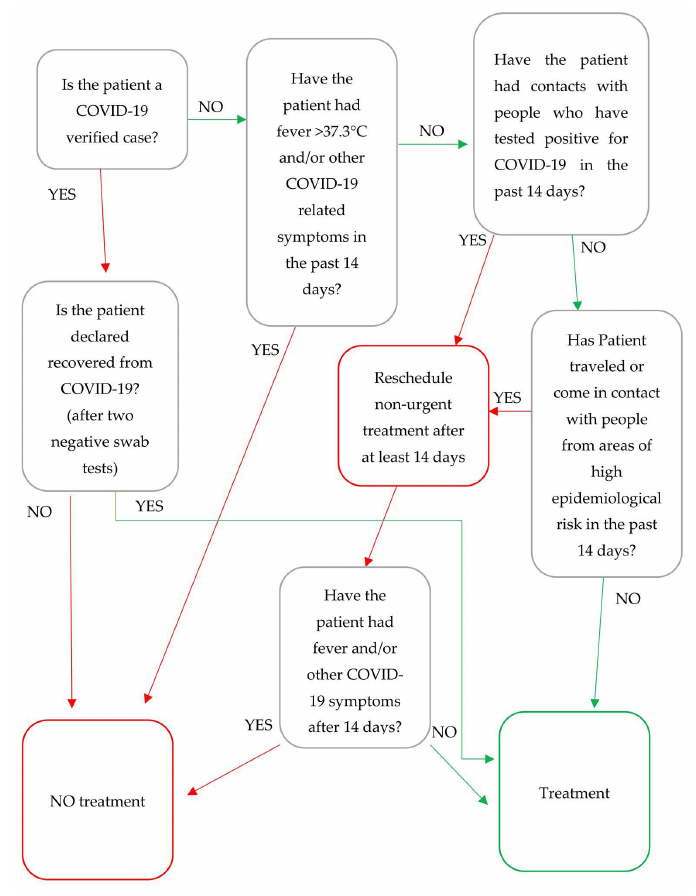
Figure 1. Patients flowchart screening for non-emergency dental